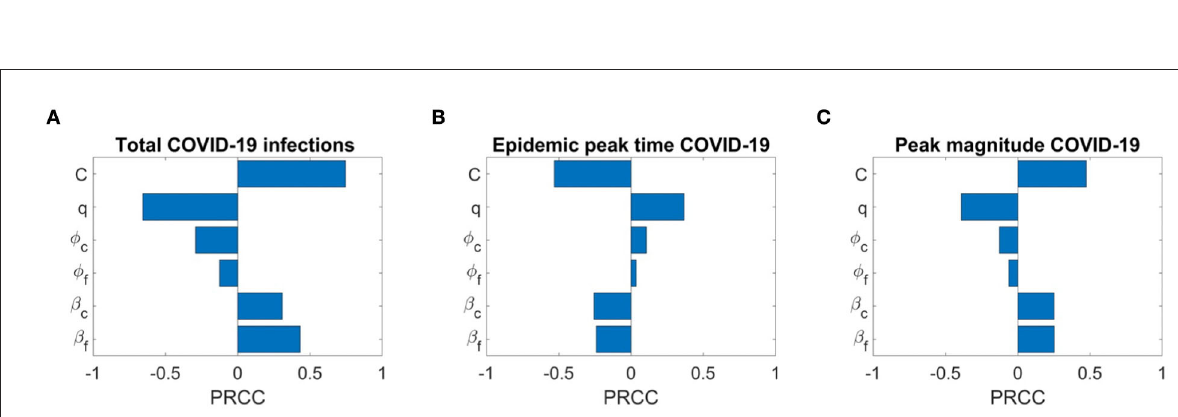
FIGURE12 Sensitivity analysis of three epidemic outcomes of COVID-19. (A–C) Total COVID-19 infections, the epidemic peak time of COVID-19, and the peak magnitude of COVID-19 respectively. The sensitivity analysis is done with 2,000